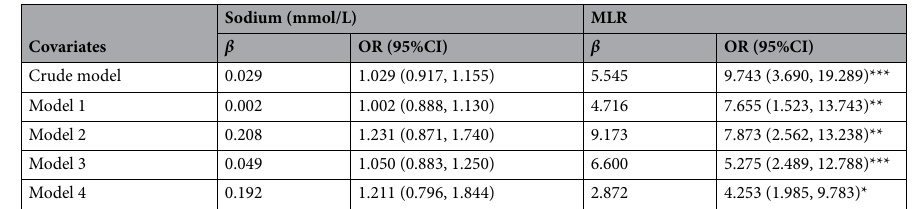
Table 6. Association of independent factors with death using multivariate logistic regression. OR odds ratio; CI confidence interval; MLR monocyte-to-lymphocyte ratio. Model 1: adjusted for age, gender, race, marital status, and education level. Model 2: adjusted for age, gender, race, marital status, and education level, BMI, positive TST, lived in household TB sick person, history of TB exposure, and TB medicine. Model 3: adjusted for age, gender, race, marital status, education level, arthritis classification, smoking status, alcohol use, and diabetes. Model 4: adjusted for all